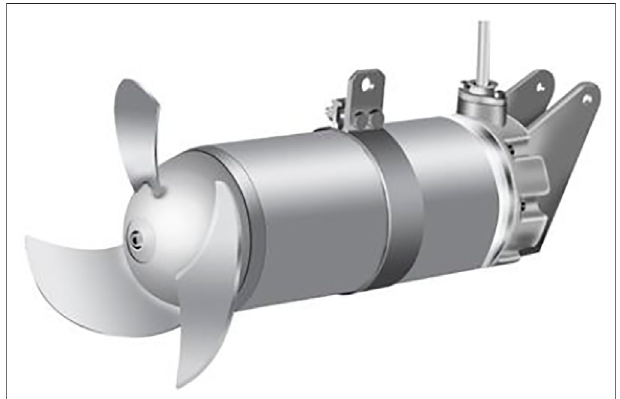
FIGURE 1 | Submersible